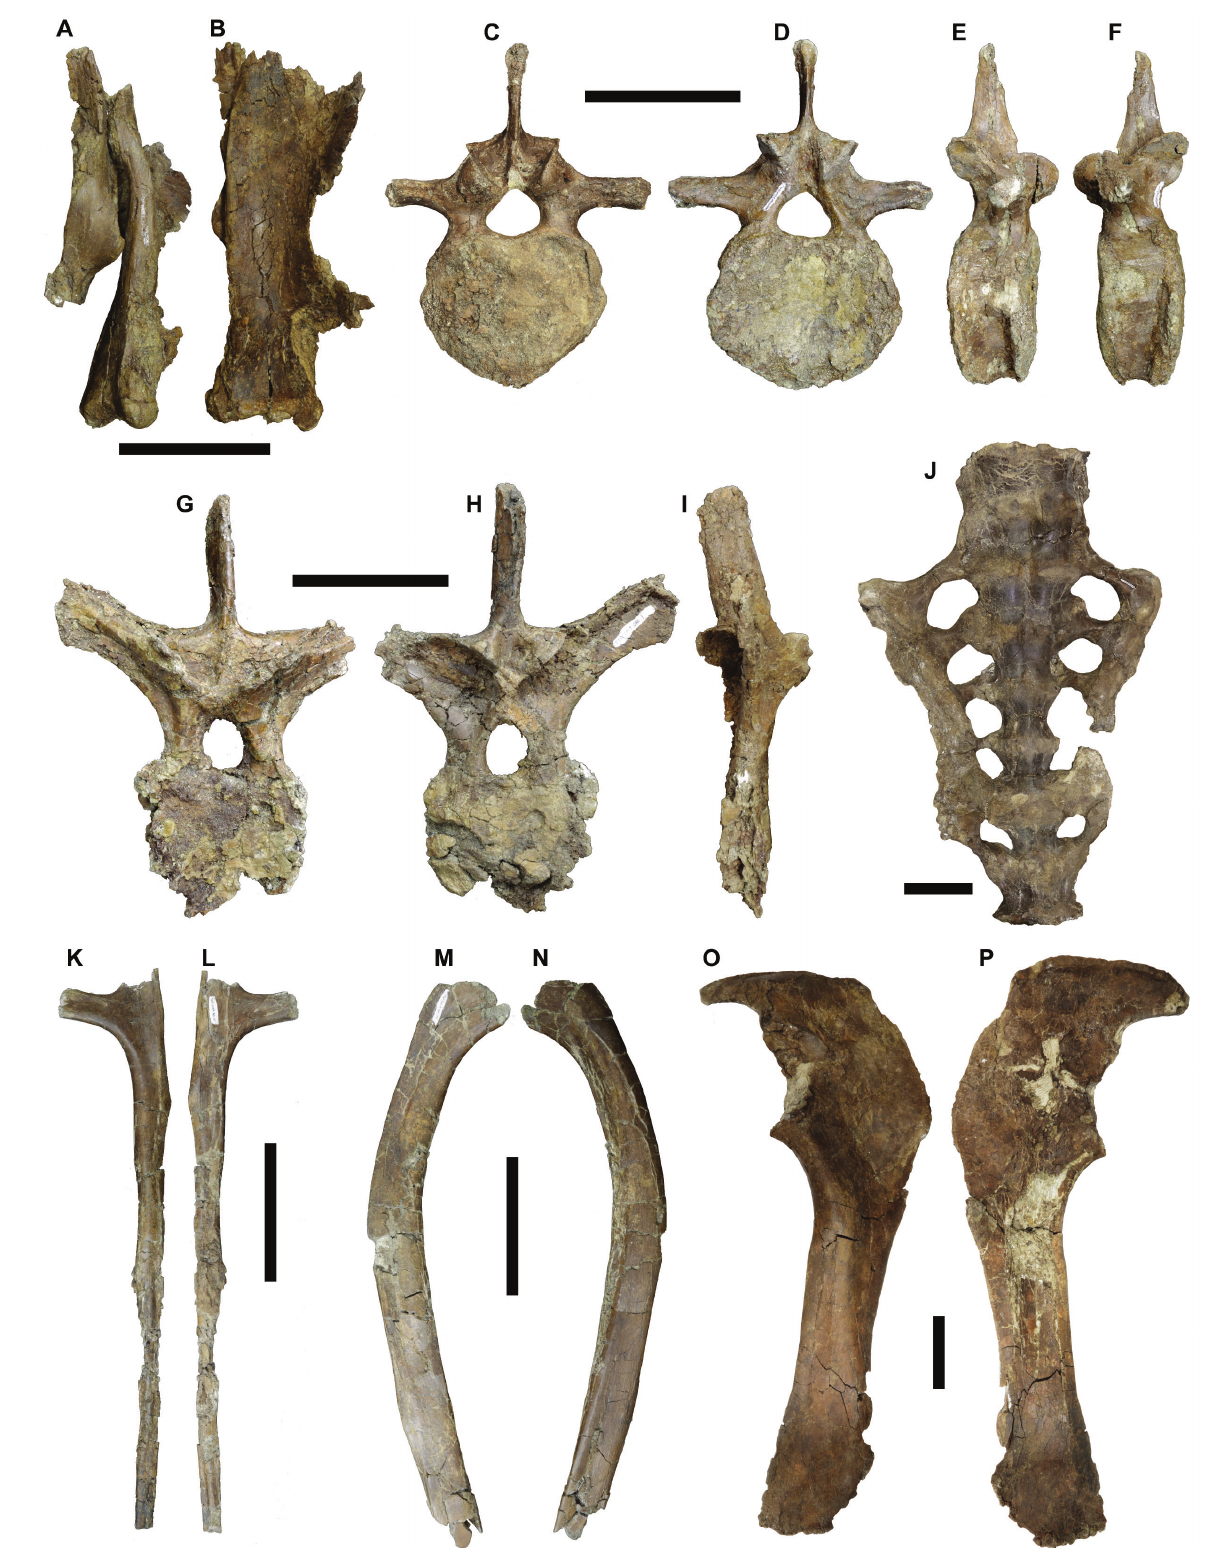
Figure 6. Photographs of associated cranial and postcranial element of TMP 2009.080.0001. A & B, associated right quadrate and quadratojugal in lateral (A) and anterior (B) views. C−F, cervical vertebrate (C5) in anterior (C), posterior (D), right lateral (E), and left laterial (F) views. G−I, dorsal vertebrate in anterior (G), posterior (H) and left lateral (I) views. J, sacrum in ventral view. K−L, posterior left cervical rib in anterior (K) and posterior (L) views. M−N, partial left dorsal rib in posterior (M) and anterior (N) views. O−P, left scapulocoracoid in lateral (O) and medial (P) views. All scale bars = 10 cm. A−I & K−N, and J & O−P are at the same